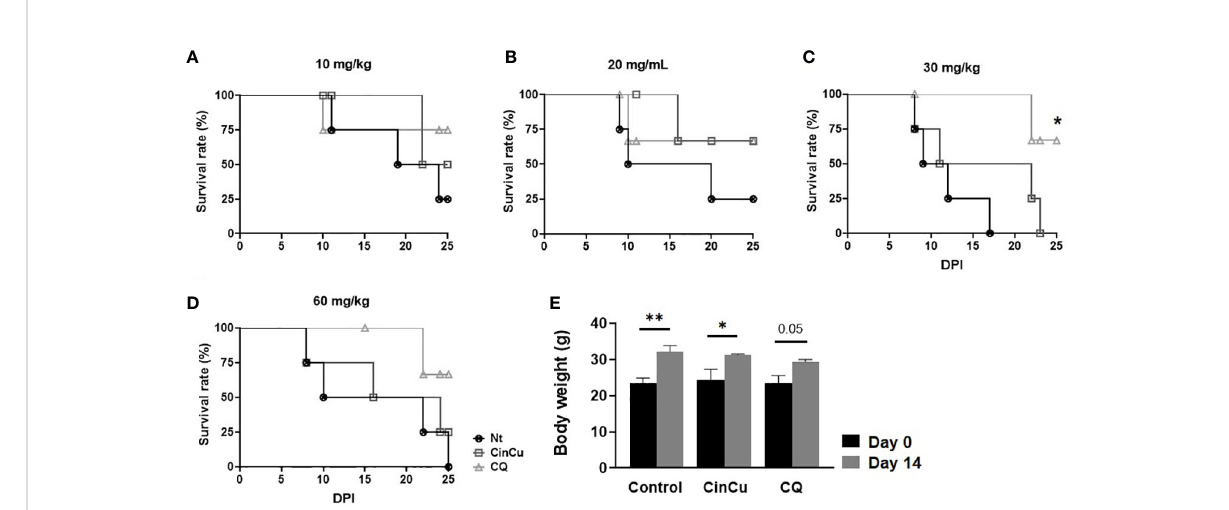
FIGURE 5 The survival rate of mice infected with P. berghei ANKA and treated with CinCu or Chloroquine. The survival rates of mice treated with 10 mg/ Kg (A) , 20 mg/Kg (B) , 30 mg/Kg (C) , and 60 mg/kg (D) were determined and analyzed by the Kaplan-Meier method with Log-rank